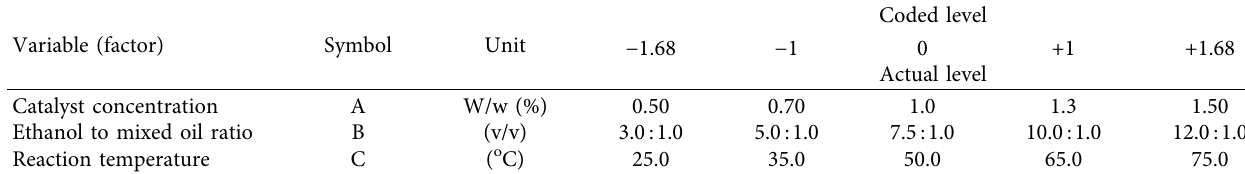
Table 2: The actual and coded values of independent variables used in the